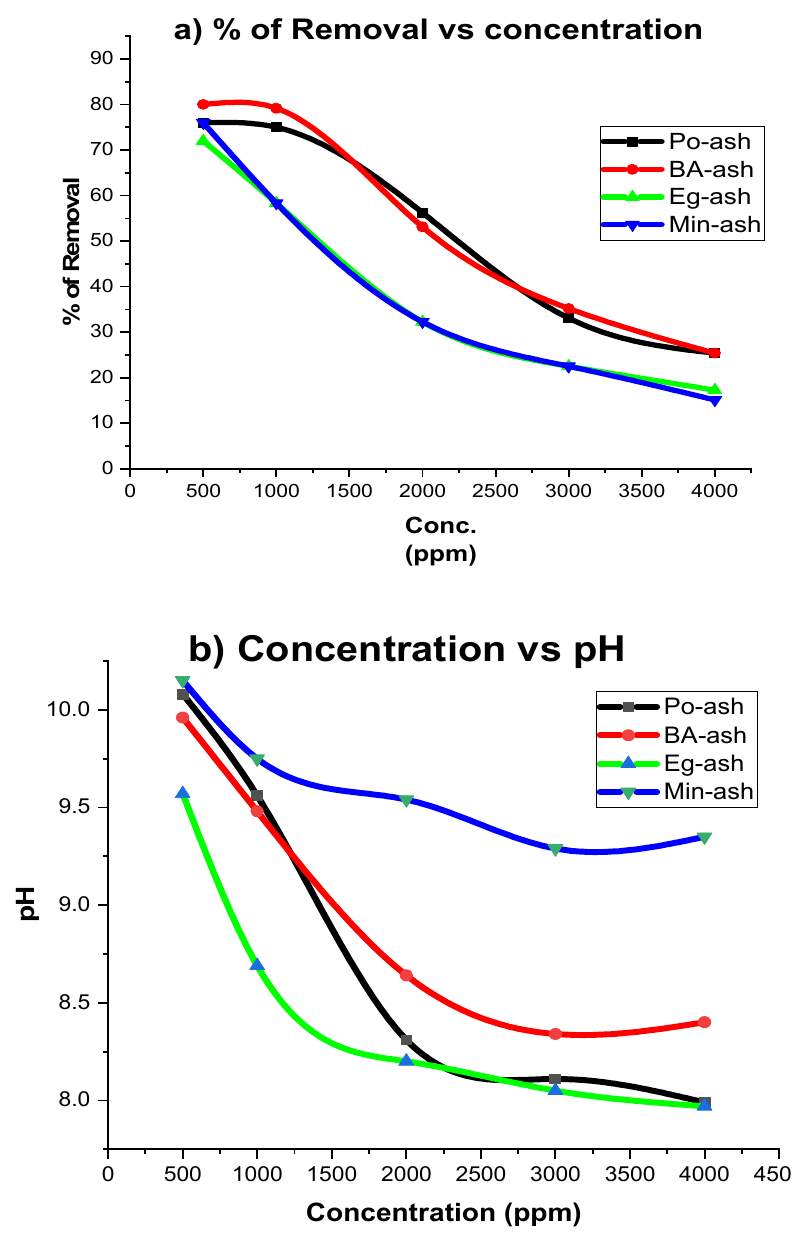
Figure 7. Influence of the initial concentrations against the removal of Ca ions in ( a ) versus the pH in ( b ) of the solution.